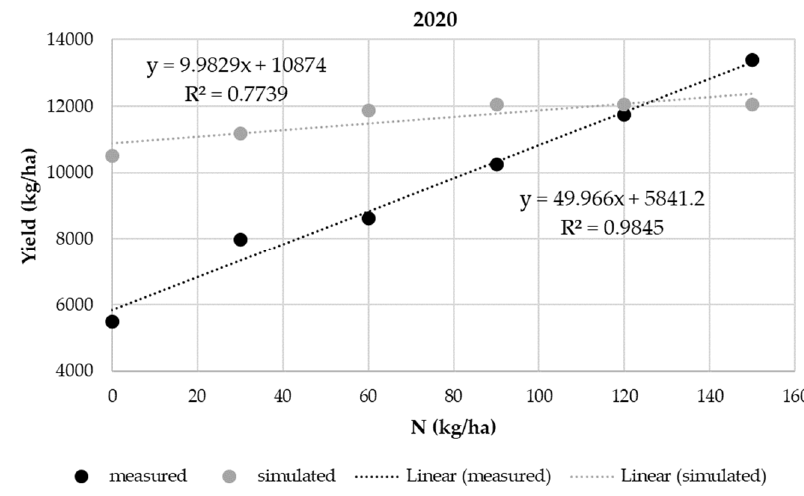
Figure 6. Comparisons between simulated and measured maize grain yield (2020).